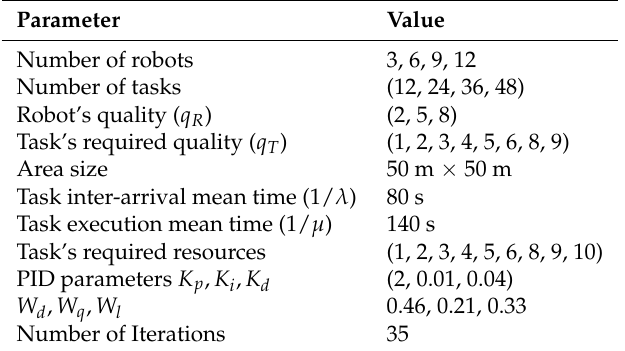
Table 2. Simulation